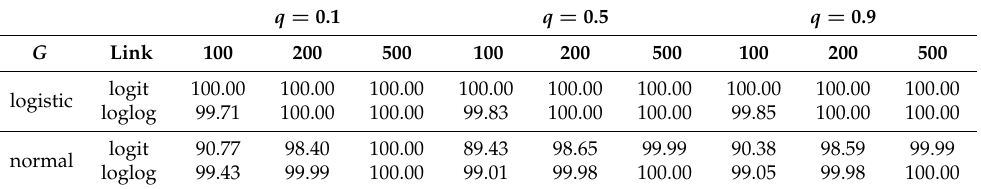
Table 4. Percentage of time where the maximization algorithm converges with theinitial value as the vector